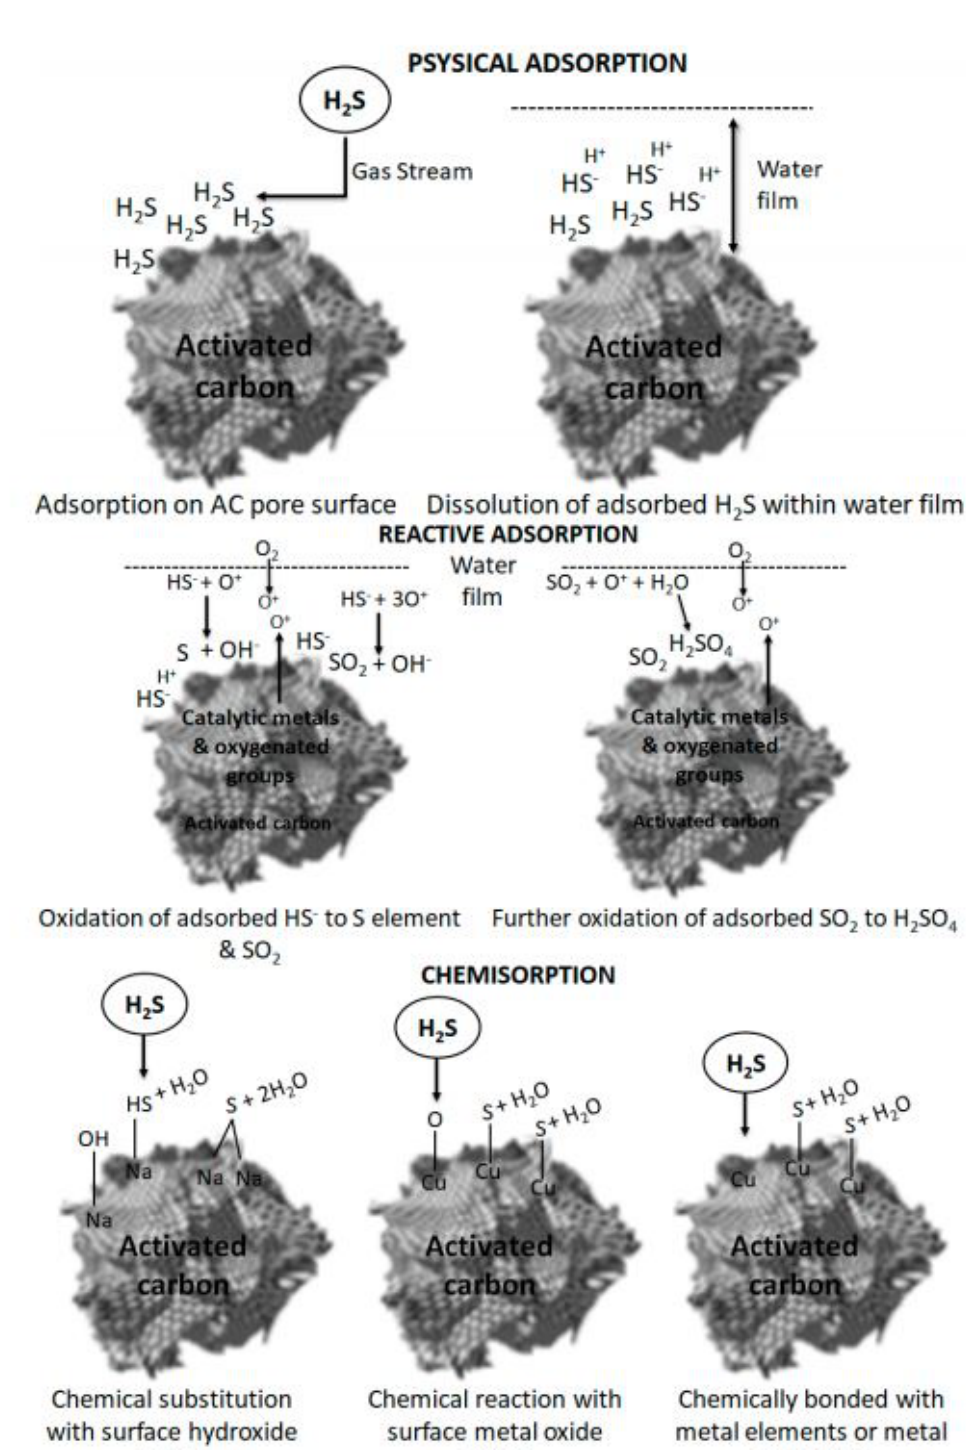
Ni(NO 3 ) 2 .6H 2 O was dissolved in a 20 mL mixture of dis- tilled water and ethanol (1:1 v/v). A 1 g of PVP that acts